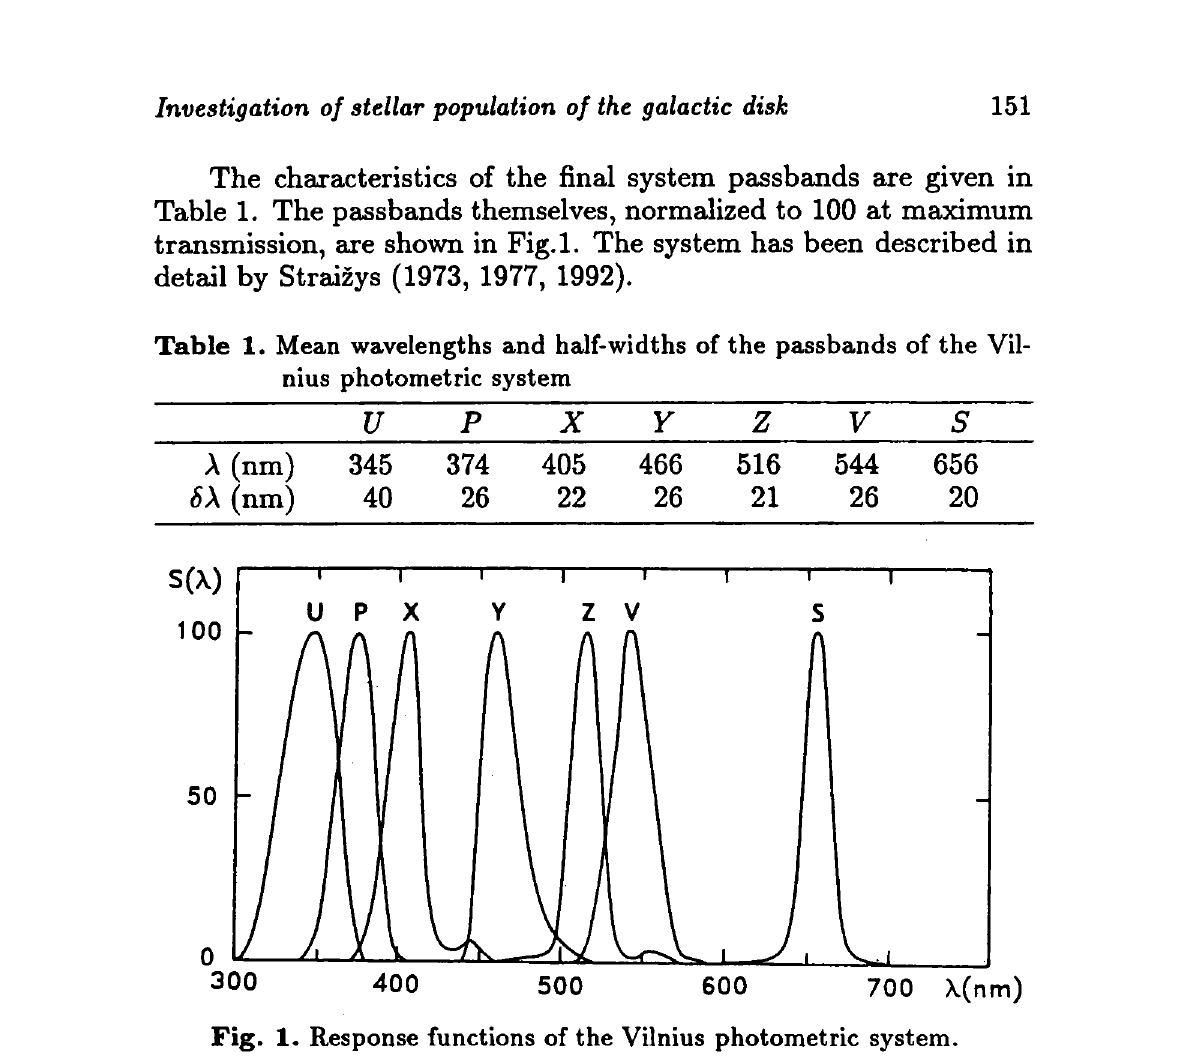
Fig. 1. Response functions of the Vilnius photometric system. The positions of the passbands, plotted aside the flux distribu- tion curves of the AO V and K5 V stars, are shown in Figs. 2 and 3. The U passband measures intensity to the ultraviolet side from the Balmer jump. The Ρ passband measures the absorption of the higher members of the Balmer series which is sensitive to surface gravity in B-A-F stars. The X passband measures the intensity to the red side from the Balmer jump for early-type stars as well as the amount of blocking by metal lines for late-type stars. The Y passband is placed near the break point of the interstellar extinction law and, in com- bination with other passbands, is important in distinguishing the temperature reddening and the interstellar reddening. The Ζ pass- band is placed on the wide absorption feature formed by the Mg